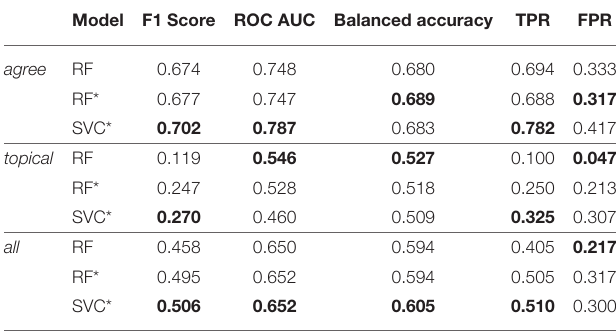
TABLE 3 | Scores for all relevance prediction models trained and evaluated with data collected based on the g-REL corpus. Model F1 Score ROC AUC Balanced accuracy TPR